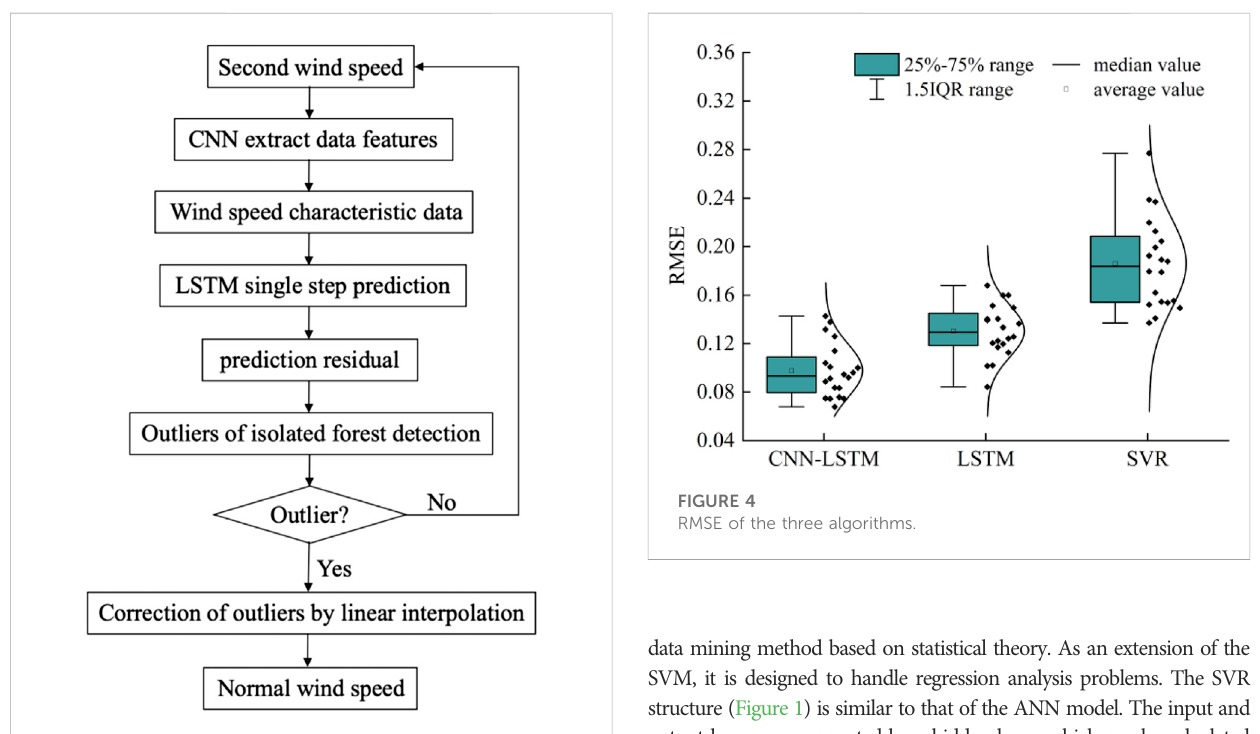
FIGURE 3 CNN – LSTM – IF fl ow.